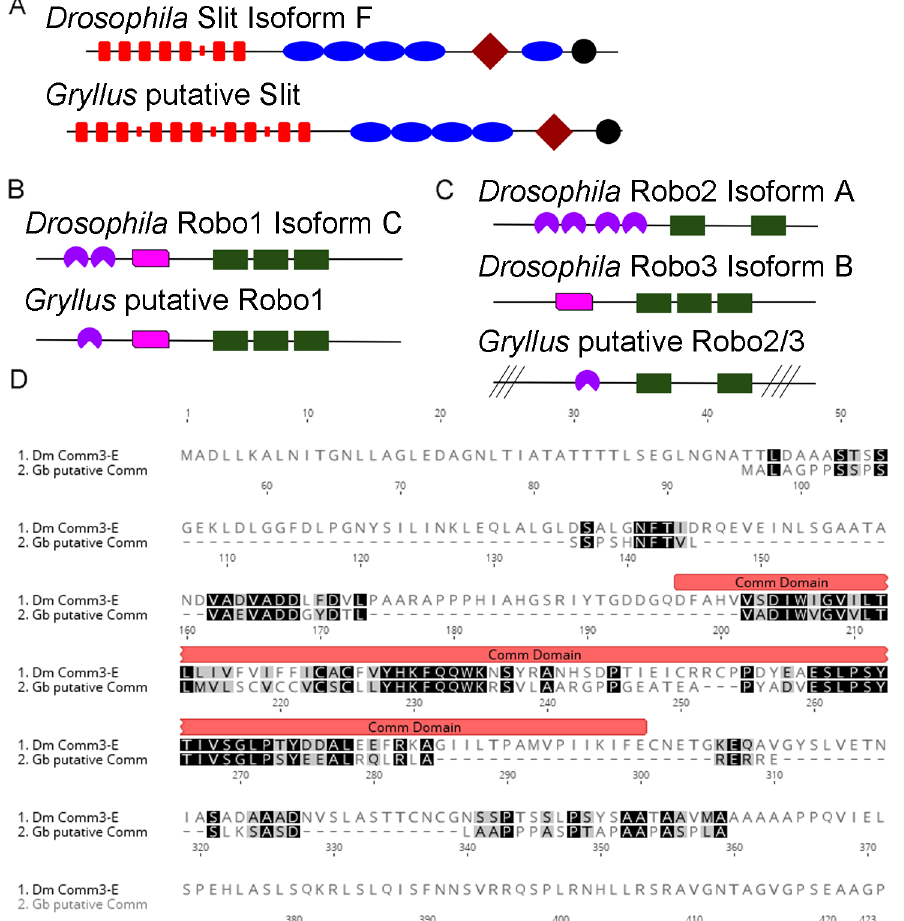
Fig 2. Components of the Slit signaling family are conserved in G . bimaculatus . A) The type, number, and order of protein domains was assessed by using Drosophila Slit, isoform F (AGB93549) and the putative G . bimaculatus Slit (TRINITY_DN152282_c0_g1_i2) as queries in a conserved domain search in NCBI. Both Drosophila and G . bimaculatus Slit had multiple leucine-rich repeats (red rectangles), though the number differed. Smaller red rectangles represent the C-terminal domain of a LRR. Drosophila Slit has five EGF domains (blue ovals), while the predicted G . bimaculatus Slit has only four. Both have a laminin G-like domain (diamond), and a C-terminal cysteine knot (black circle). B) An NCBI conserved domain search was used to identify the domains present in Drosophila Robo1, isoform C (AAM71113) and putative G . bimaculatus Robo1 (TRINITY_DN172482_c0_g4_i2), which included one or two IG domains (purple circular sectors) and an Ig I-set domain (pink). In addition, both predicated Robo1 proteins had three Fibronectin-type 3 domains (green rectangles). C) An NCBI conserved domain search was used to identify the domains present in Drosophila Robo2, isoform A (AAF51375) and Robo3, isoform B (AGB92403) and putative G . bimaculatus Robo2/3 (TRINITY_DN174950_c3_g2_i1). Both Drosophila Robos had several Ig domains predicted, but only Robo 2 showed specific hits in the conserved domain search (purple). Drosophila Robo3, isoform A possessed a single Ig I-set domain. These Robos had either three or two fibronectin-type 3 domains (green rectangles). The predicted G . bimaculatus Robo2/3 has characteristics that matched Robo 2 better (at least one Ig domain), though the overall sequence similarity was closer to Robo 3, isoform B. D) Alignment of Commisureless from G . bimaculatus (Gb putative Comm) and Drosophila melanogaster (Dm Comm3-E). Black shading indicates identical amino acids, gray shading indicates amino acids. The Drosophila comm domain is noted by a red bar above the sequence. The search for G . bimaculatus Robo encoding transcripts also returned numerous hits with low E-values, specifically five with E-values of 0.0 for Robo1 and two with E-values of 0.0 for Robo3. Results identical to the Robo3 search were obtained when searching the transcriptome using Robo2 as a query. Translation of the top hit from the Robo1 search,